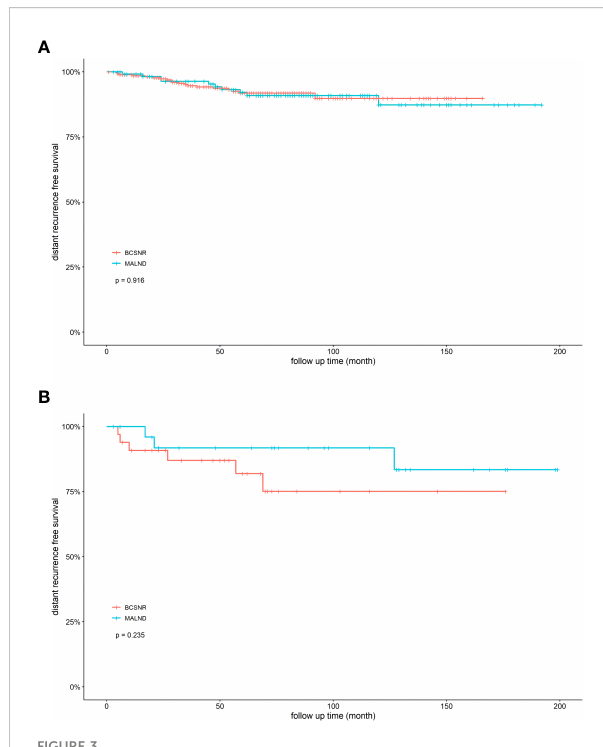
FIGURE 3 Distant recurrence free survival for elderly breast cancer patients. (A) luminal patients with BCSNR and MALND. (B) TNBC patients with BCSNR and MALND.